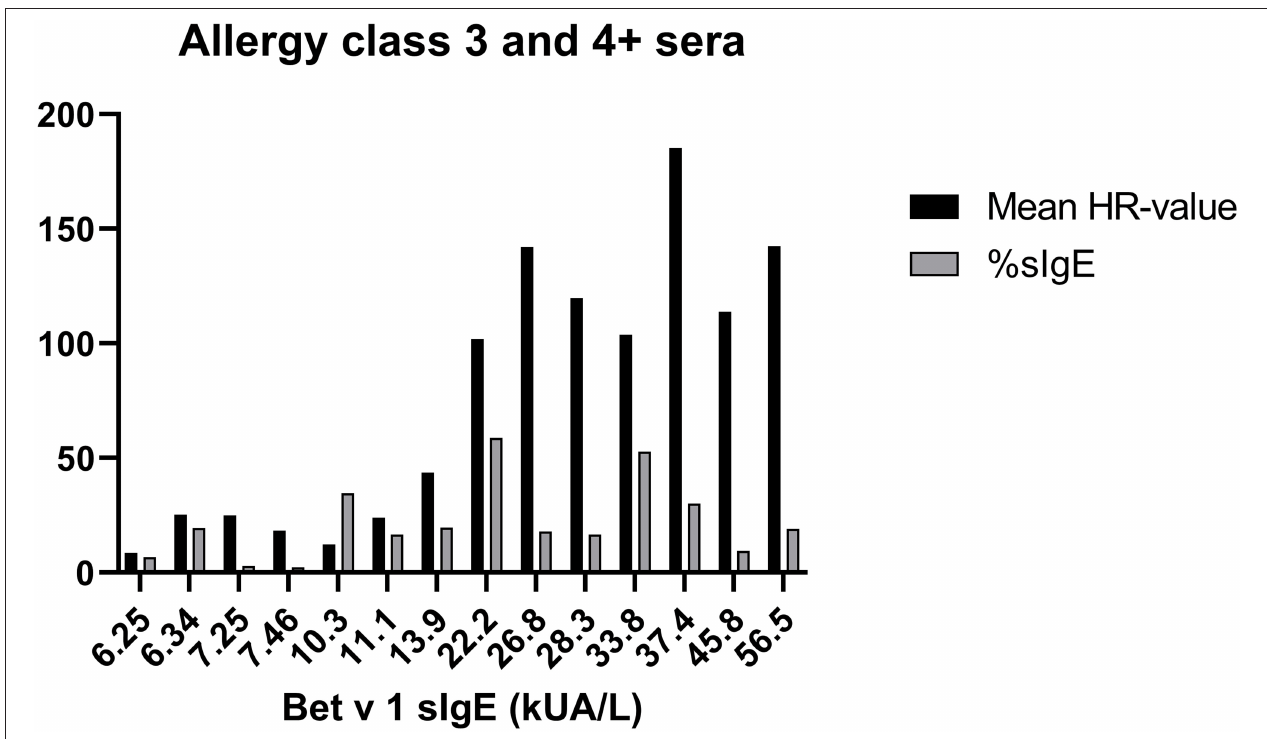
FIGURE 3 | Data from sera in allergy classes 3 and 4 + are shown; Bet v 1 concentration (kU/l) at the x-axes, mean of the HR-value from the 3 experiments in black column, % of Bet v 1 sIgE (%sIgE) in gray column.